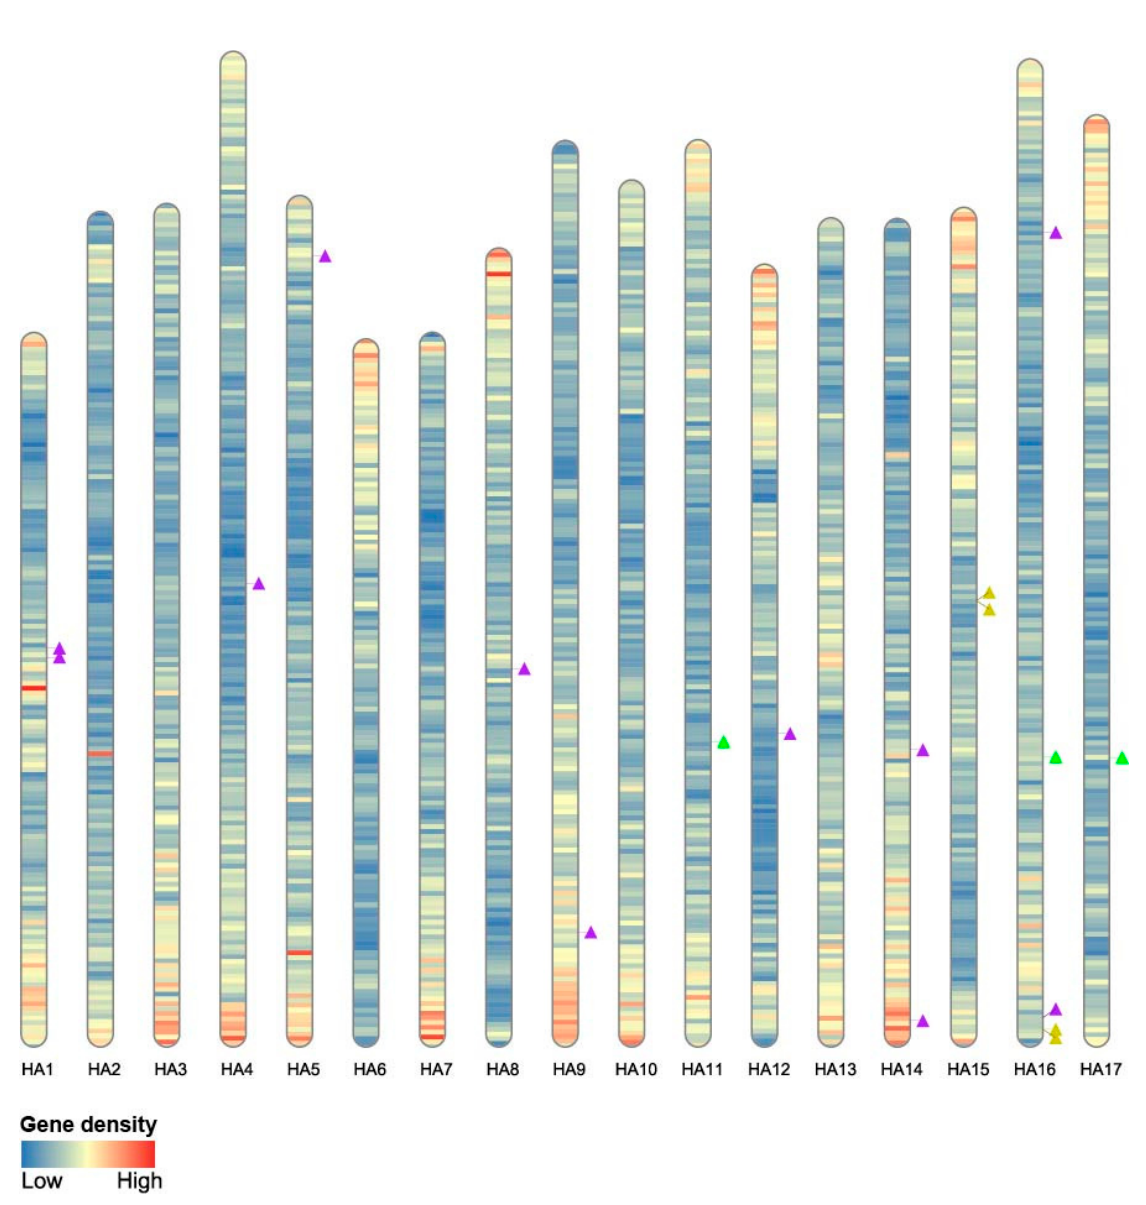
Figure 2. Localization of HaWOX genes on the 17 chromosomes of Helianthus annuus . Genes corresponding to HaWOX sequences are visualized as a triangle for ancient (yellow), intermediate (green), and WUS (purple) clades. HA1-17 = Helianthus annuus chromosomes.